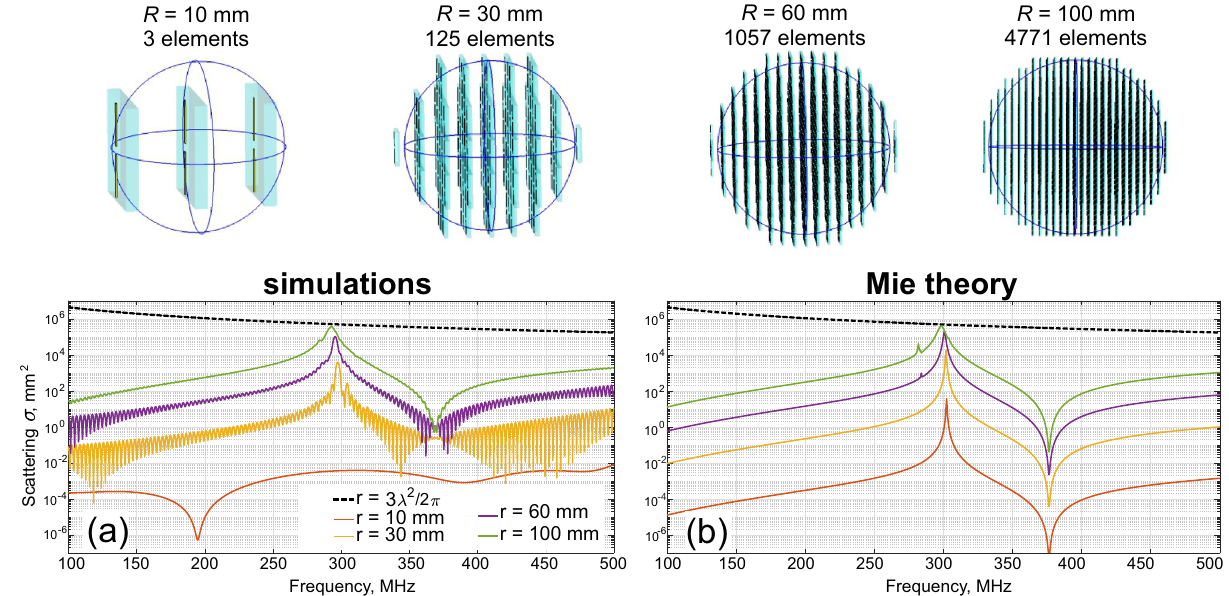
Figure 3. Scattering cross-section spectra of subwavelength spheres, numerical analysis. ( a ) Metamaterial- based scatterers (geometries are in the upper insets). ( b ) Homogeneous spheres, with the parameters, retrieved from Fig. 2, lossy case). Different sizes correspond to solid color lines, elaborated in the captions. The dashed black line shows a theoretical single-channel limit for the dipolar scatterer. Insets are the granular metamaterial scatterers, analyzed in panel ( a